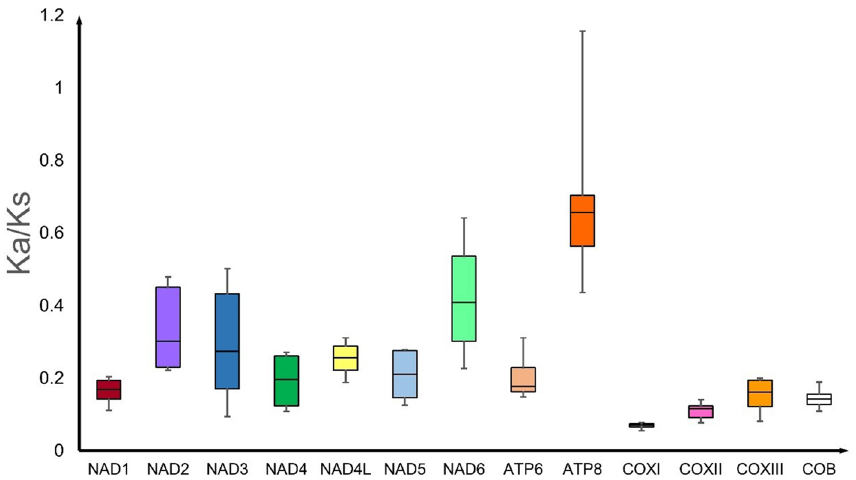
Figure 3. Box plot for pairwise divergence of Ka/Ks ratio (mean ± SD, and range) for 13 PCGs of Nephila (n = 1) and Trichonephila (n = 3) mitogenomes generated using DnaSP6.0. (http:// www. ub. edu/